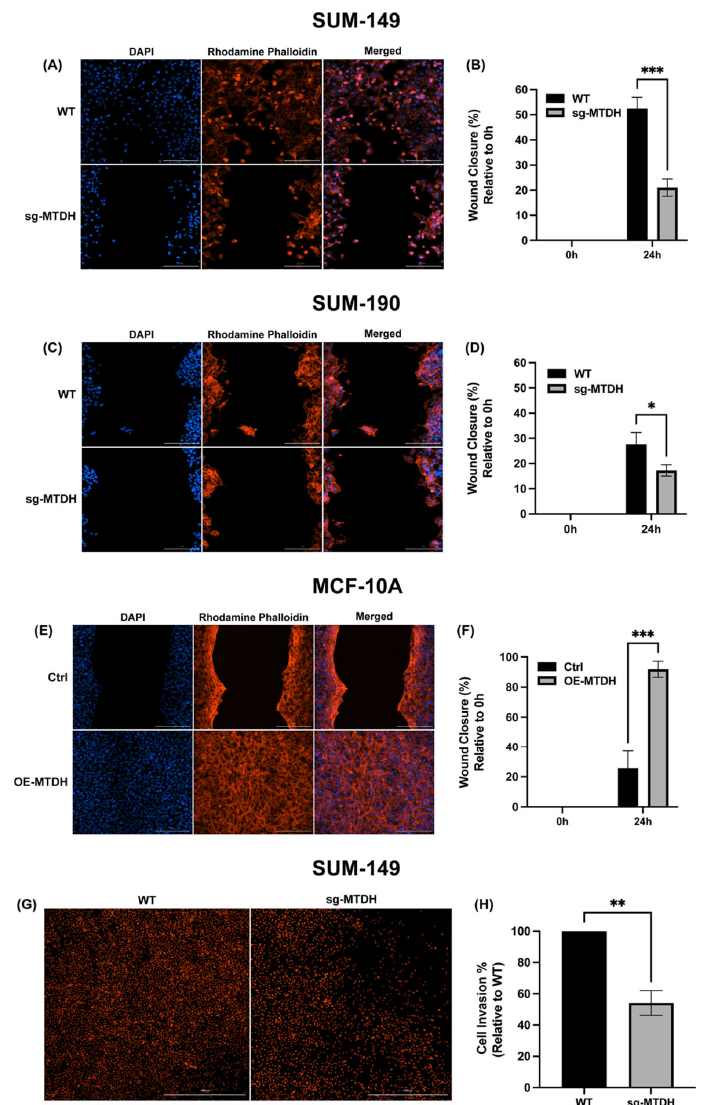
Figure 4. MTDH depletion modulates the motility and invasive capacity of IBC cells. ( A , B ) Micro- graphs of the wound healing assay and wound closure (%) results of SUM-149 WT and sg-MTDH with cells seeded in Ibidi ® silicone insert plates and incubated for 24 h. ( C , D ) Micrographs from the wound healing assay and wound closure results for SUM-190 WT and sg-MTDH. ( E , F ) Wound healing assay micrographs and wound closure (%) results of MCF-10A Ctrl and OE-MTDH cells. The width of the wound was calculated by measuring the distance between the edges of the wound on the micrographs taken at 4 × using Olympus CellSense Imaging Software. The percentage of